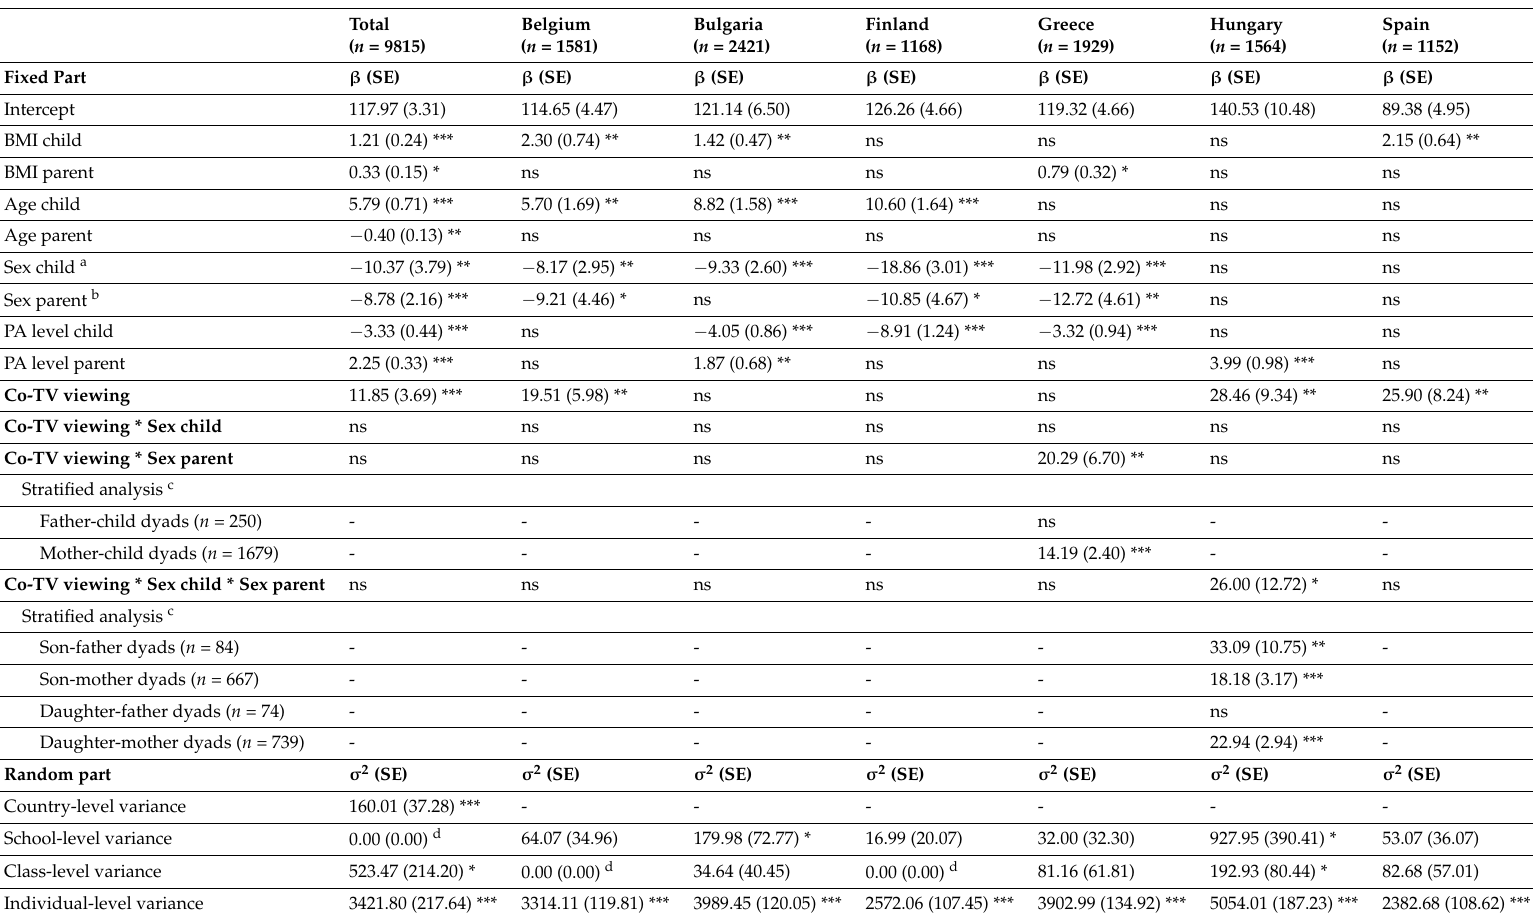
Table 2. Screen time of the child. Results of multilevel model analyses on children (cid:48) s screen time (min/day) (full